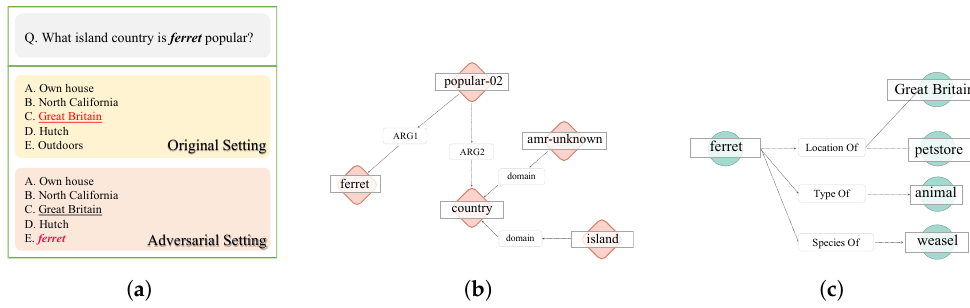
Figure 1. (( a ) Adversarial Attack in Commonsense Question Answering Task) Comparison of the prediction of the BERT-base-cased model between the original and adversarial settings. Bold texts indicate the randomly selected argument among the arguments of the sentences. The underlined option is the correct answer and the red colored option indicates the predicted answer from the pre-trained language model, (( b ) Example of AMR graph of question) Example of AMR graph of a question, and (( c ) Example of ConceptNet subgraph of question) Example of ConceptNet